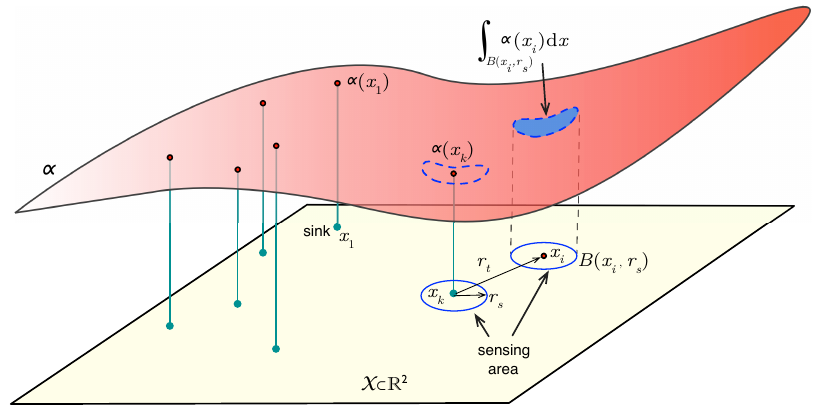
Figure 2. Problem description.